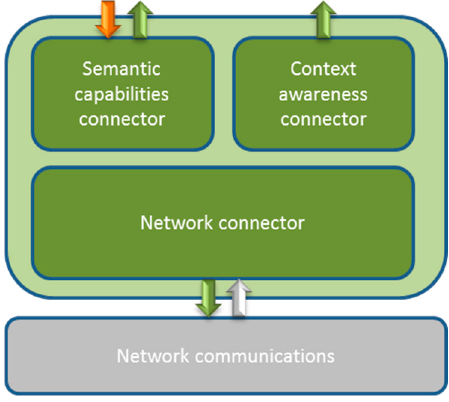
Figure 9. Data processing done in the Hardware adaptor module.